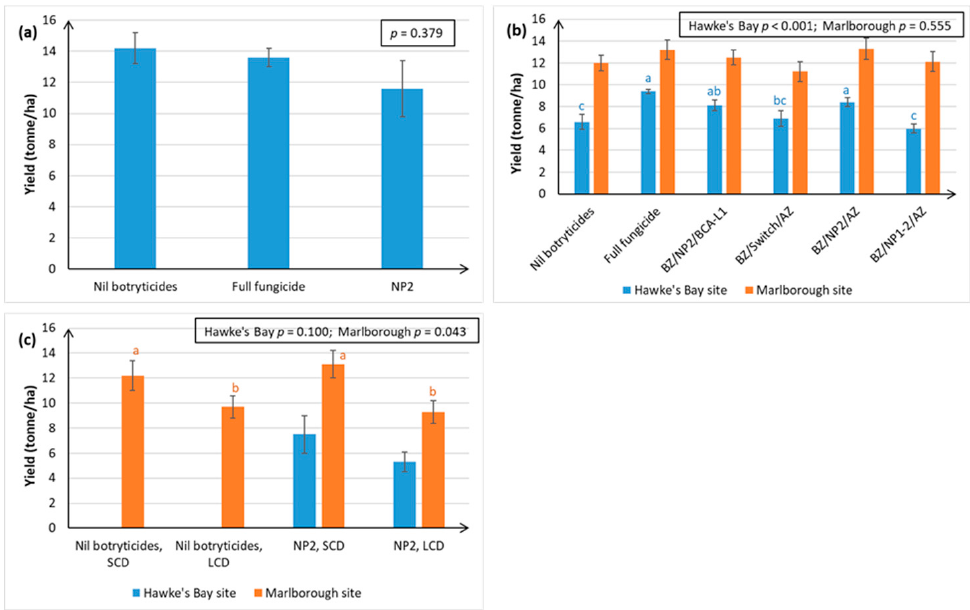
Figure 10. Fruit yield (kg/vine or tonne/ha) in Sauvignon Blanc grapes, as assessed at harvest in April, over three successive seasons. Treatments are described in full in Tables S1 and S2, and briefly in Figures 1 and 3. Each graph represents data from a separate season. Error bars indicate standard errors, boxed values show ANOVA probabilities, and different letters